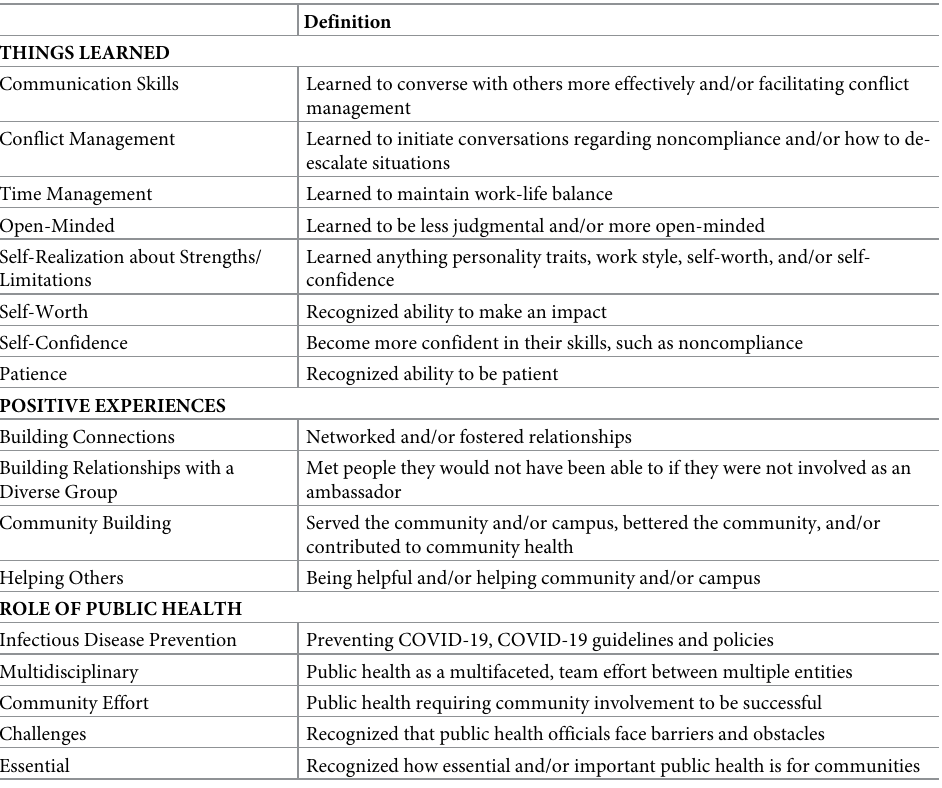
Table 2. Definitions of types of lessons